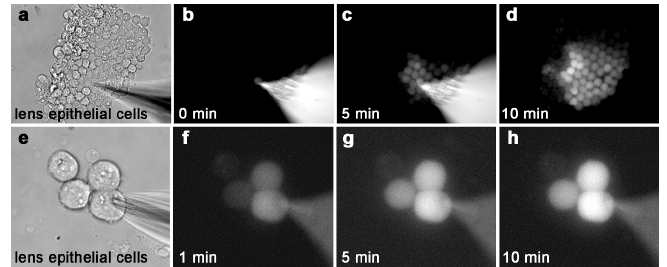
Figure 1. ε -cAMP passes through gap junction channels between primary lens epithelial cells. ( a ) A large cluster of explanted primary lens epithelial cells. ( b ) At time = 0 min, a patch pipette is opened, delivering ε -cAMP to one cell within the cluster. ( c ) Five minutes later, many cells within the cluster receive ε -cAMP from the single source cell. ( d ) After 10 min, more than half of the cells are labeled with ε -cAMP. In this image, the patch pipette was removed for clarity. ( e ) A group of four explanted primary lens epithelial cells. ( f – h ) A single wildtype epithelial cell loaded with ε -cAMP transferred the dye to two out of three neighboring cells within 10 min. Magnification a–d = 170x, e–h 730 ×